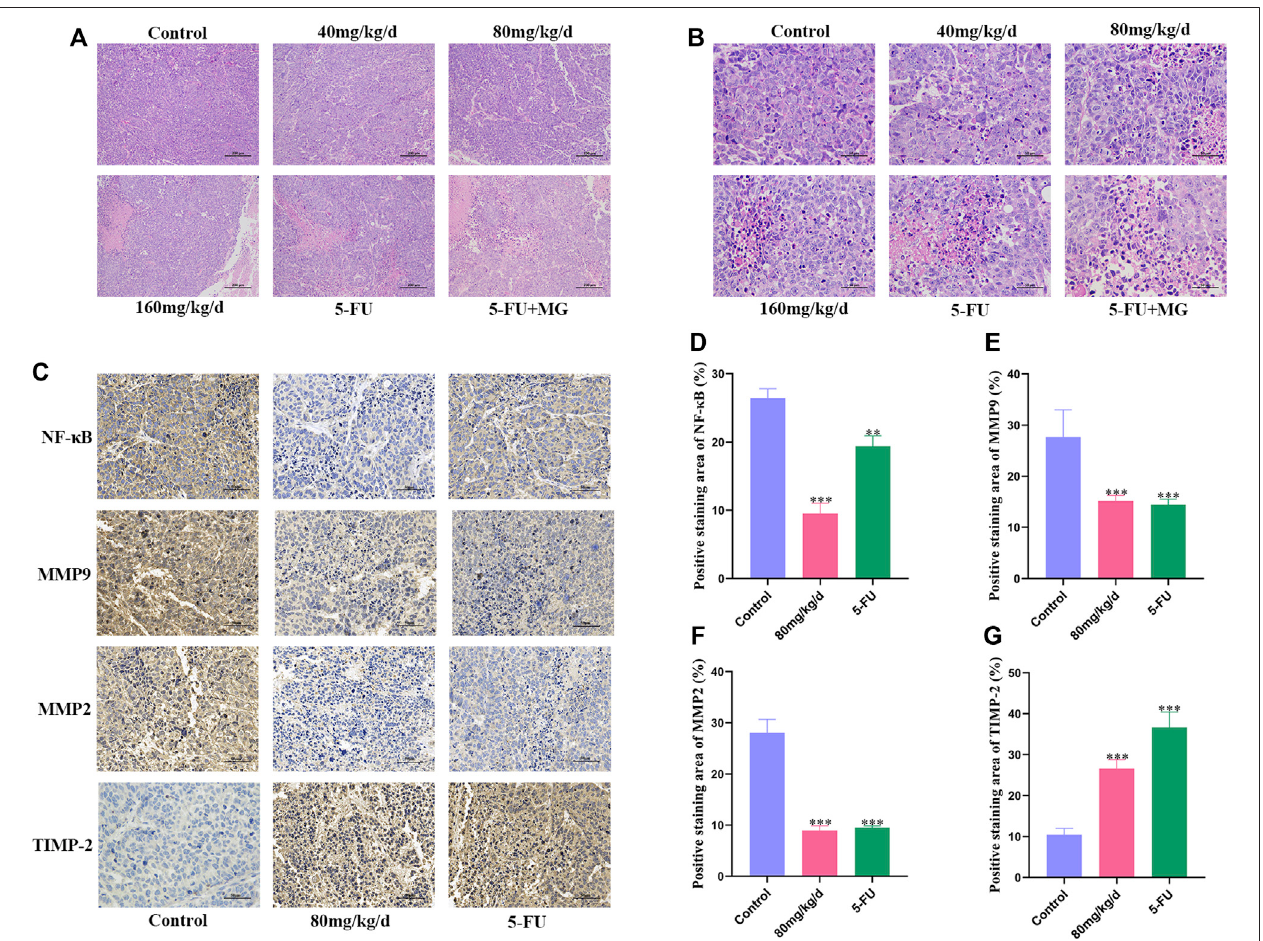
FIGURE 5 | Effect of methyl gallate (MG) on histology of xenografts in nude mice. (A – B) Representative photograph of hematoxylin – eosin staining of xenografts, original magni fi cation: (A) 10 ×; (B) 40 ×. (C) Immunohistochemical staining of NF- κ B, MMP9, MMP2 and TIMP-2 in tumors of nude mice. (D – G) The positive staining results of NF- κ B, MMP9, MMP2 and TIMP-2 were analyzed and quanti fi ed by Image J.